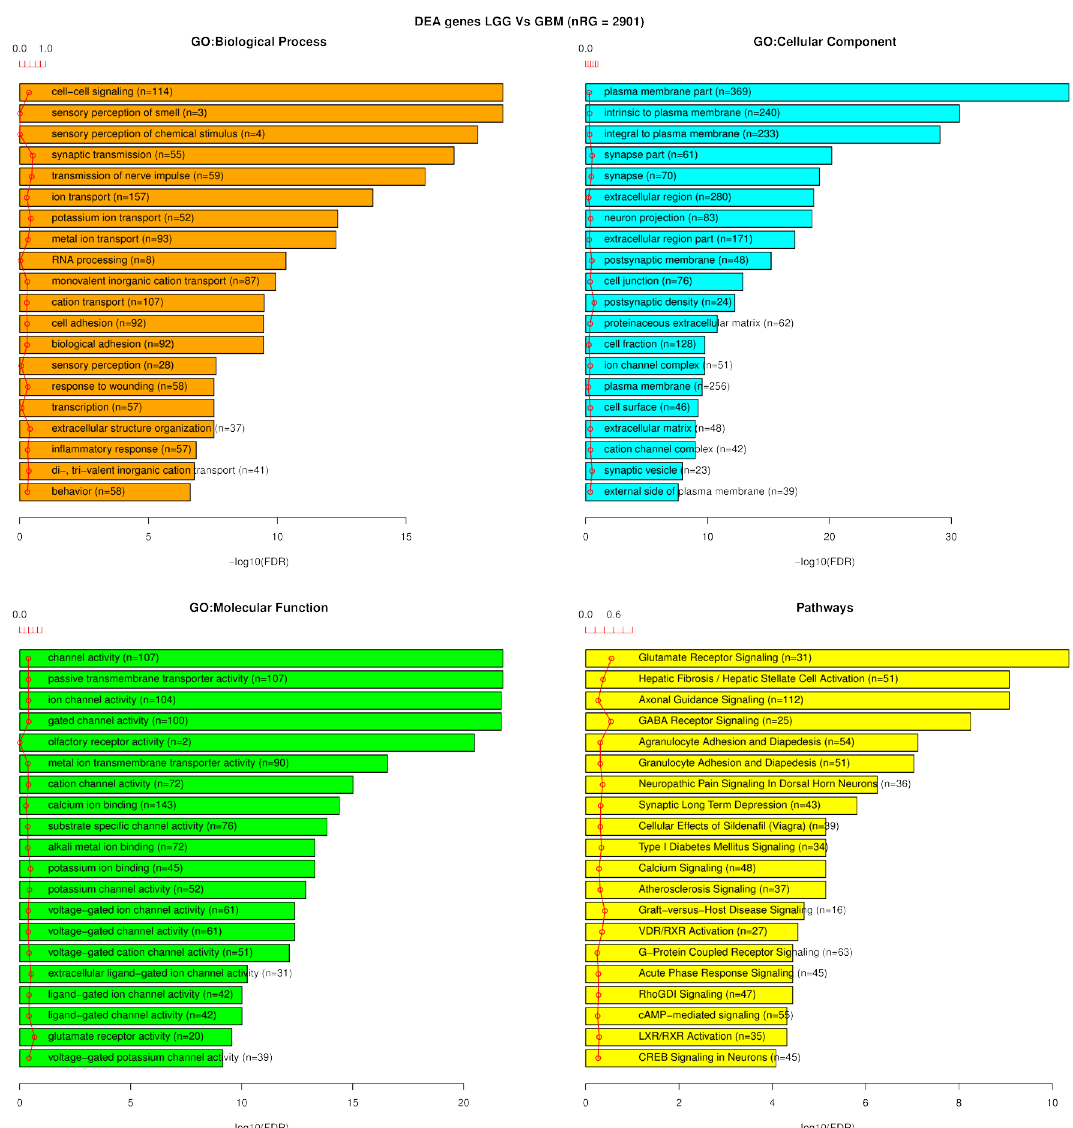
Figure 5. The plot shows canonical pathways significantly over-represented (enriched) by the DEGs (differentially expressed genes) with the number of genes for the main categories of three ontologies (GO:biological process, GO:cellular component, and GO:molecular function, respectively). The most statistically significant canonical pathways identified in DEGs are listed according to their p-value corrected FDR (-Log10) (colored bars) and the ratio of listed genes found in each pathway over the total number of genes in that pathway (ratio, red